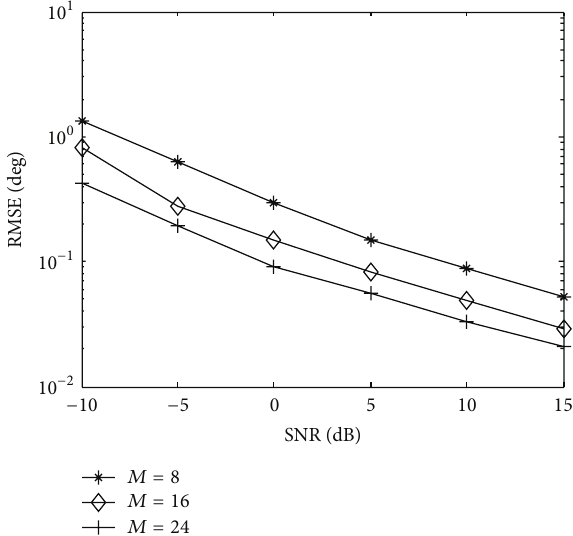
Figure 9: Angle estimation performance of our algorithm with different 𝑀 ( 𝑁 = 16 , 𝐿 = 100 , and 𝐾 = 3 ).